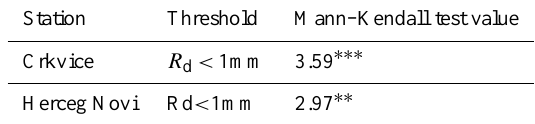
Table 4. Trend analysis of number of dry days for the Crkvice and Herceg Novi station (with statistical significance values)